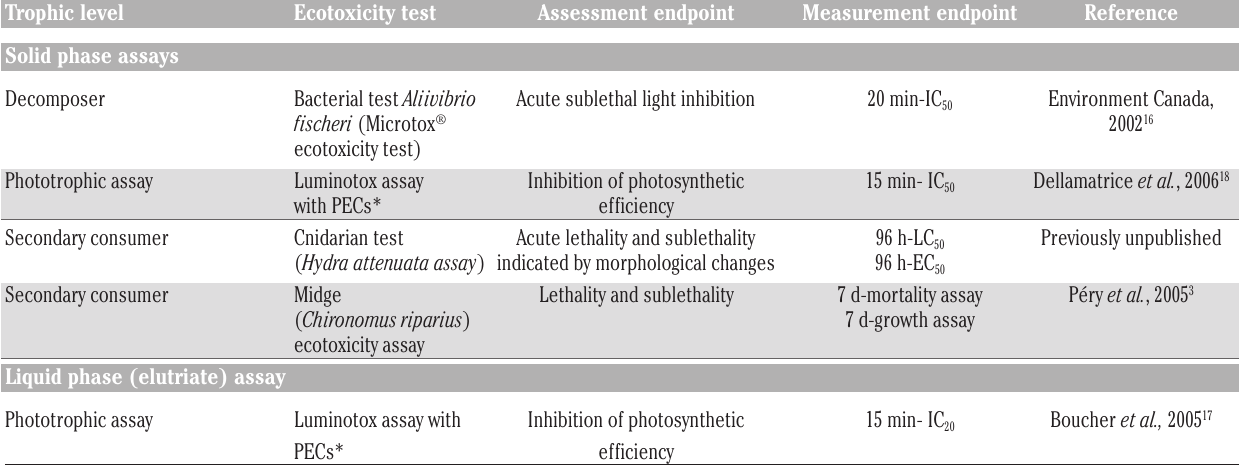
Table 2. Characteristics of the small-scale bioassays used to determine the ecotoxic potential of the seven